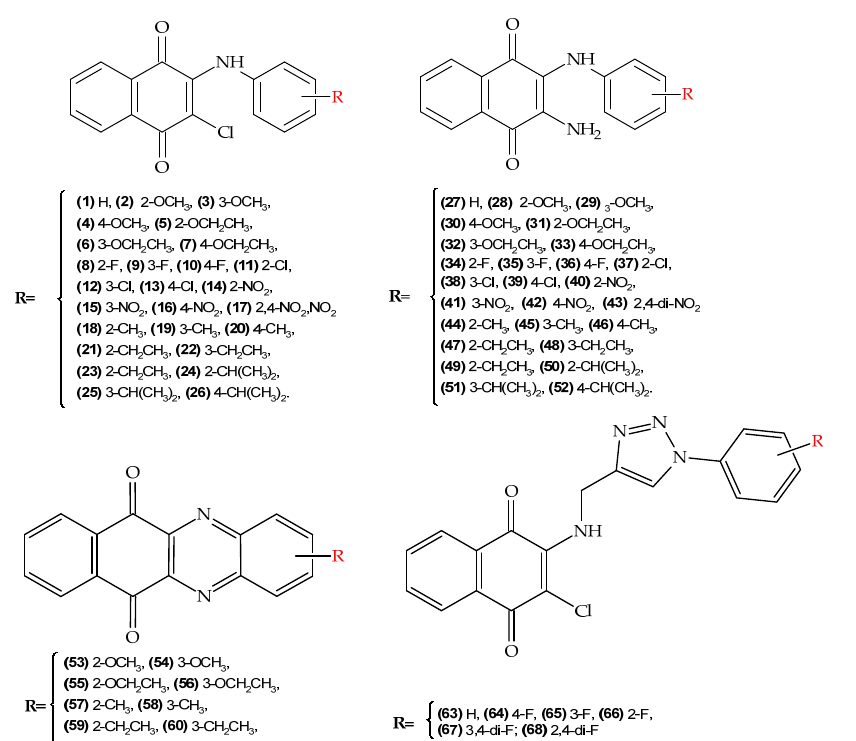
Figure 4. Molecular design of 1,4-naphthoquinone derivatives with potential antiparasitic activity (chagas and leishmaniasis). ( Top-left ) (NQ–Chlorine family), ( top-right ) (NQ–Amine family), ( bottom-left ) (NQ–Phenazine), and ( bottom-right ) (NQ–Triazole family).